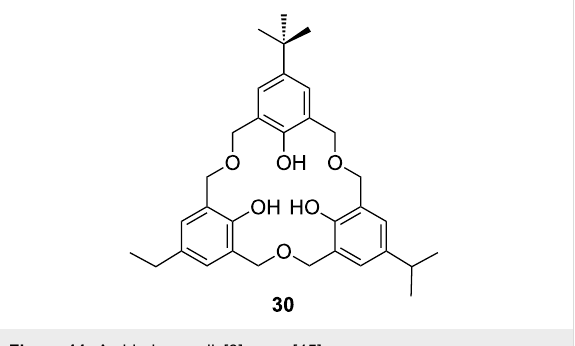
Figure 11: A chiral oxacalix[3]arene [45].